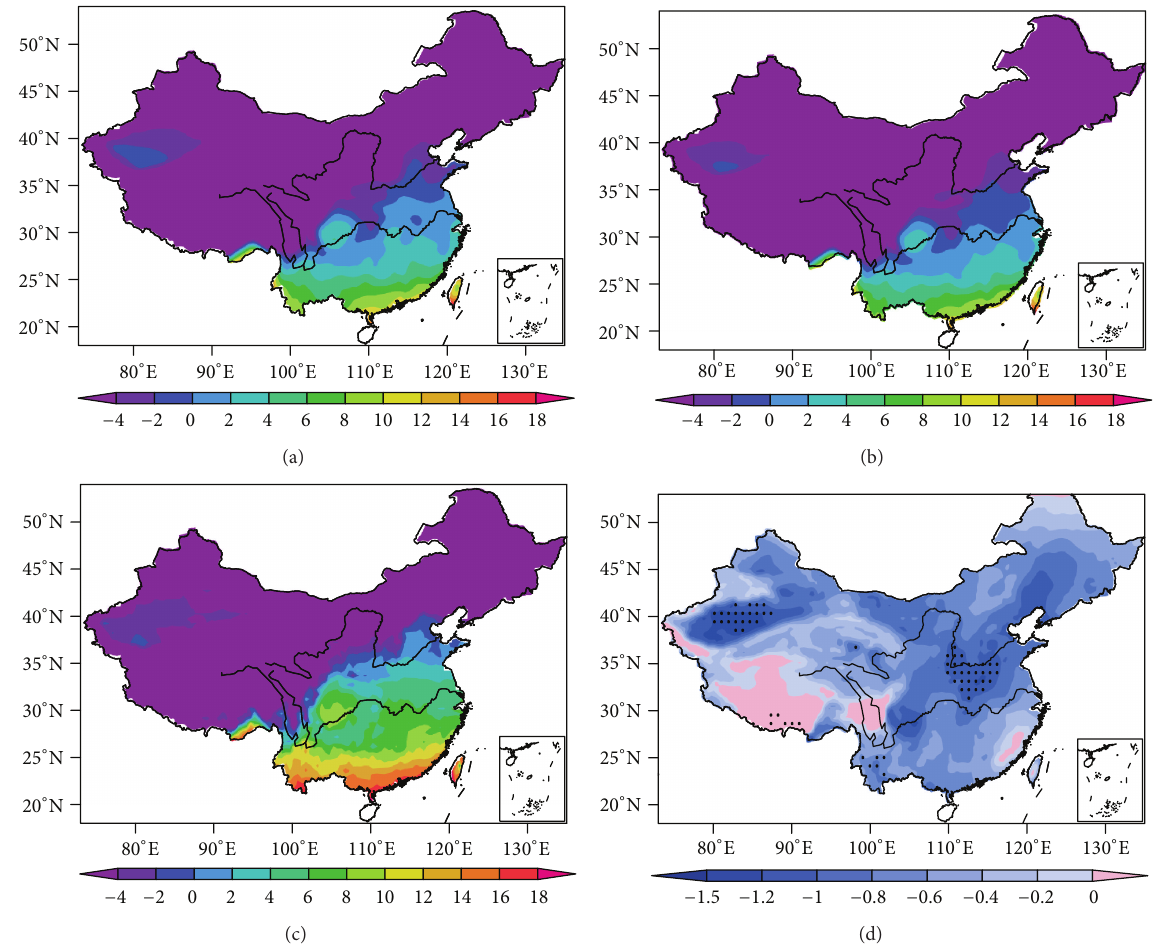
Figure 7: Surface air temperature at 2 m ( ∘ C) for (a) Nodust, (b) Dust, (c) CRU, and (d) difference between Dust and Nodust experiments averaged in winter during 2000–2009 period; the black dotted area in (d) indicates areas in which the difference is statistically significant at the 95% confidence level (Student’s t -test).